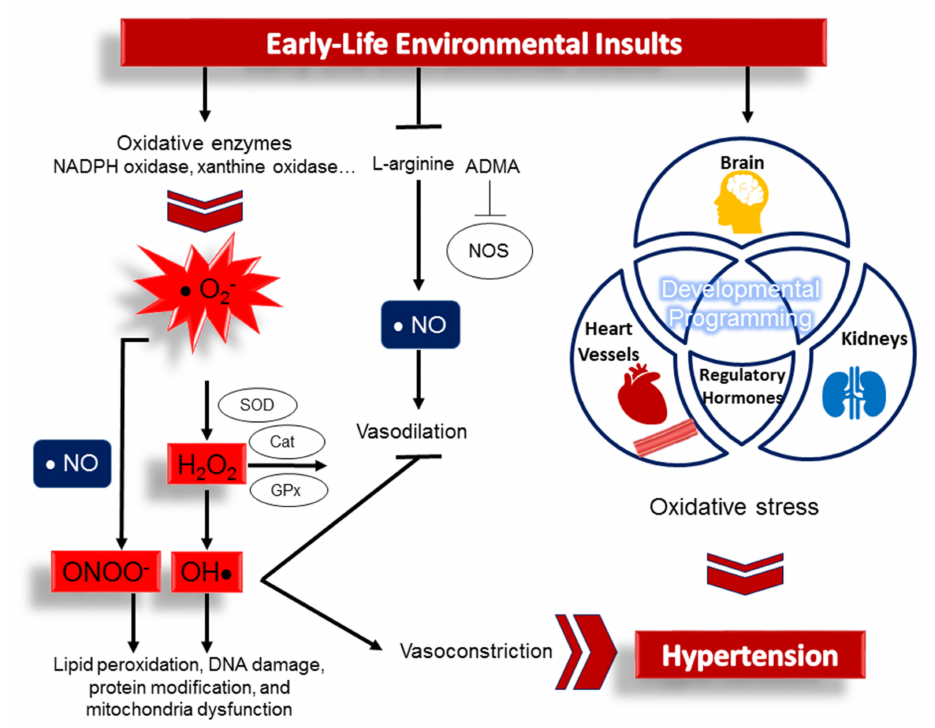
Figure 1. Schema outlining how early-life environmental insults induce hypertension in later life via oxidative stress programming of various organ systems and regulatory hormones.